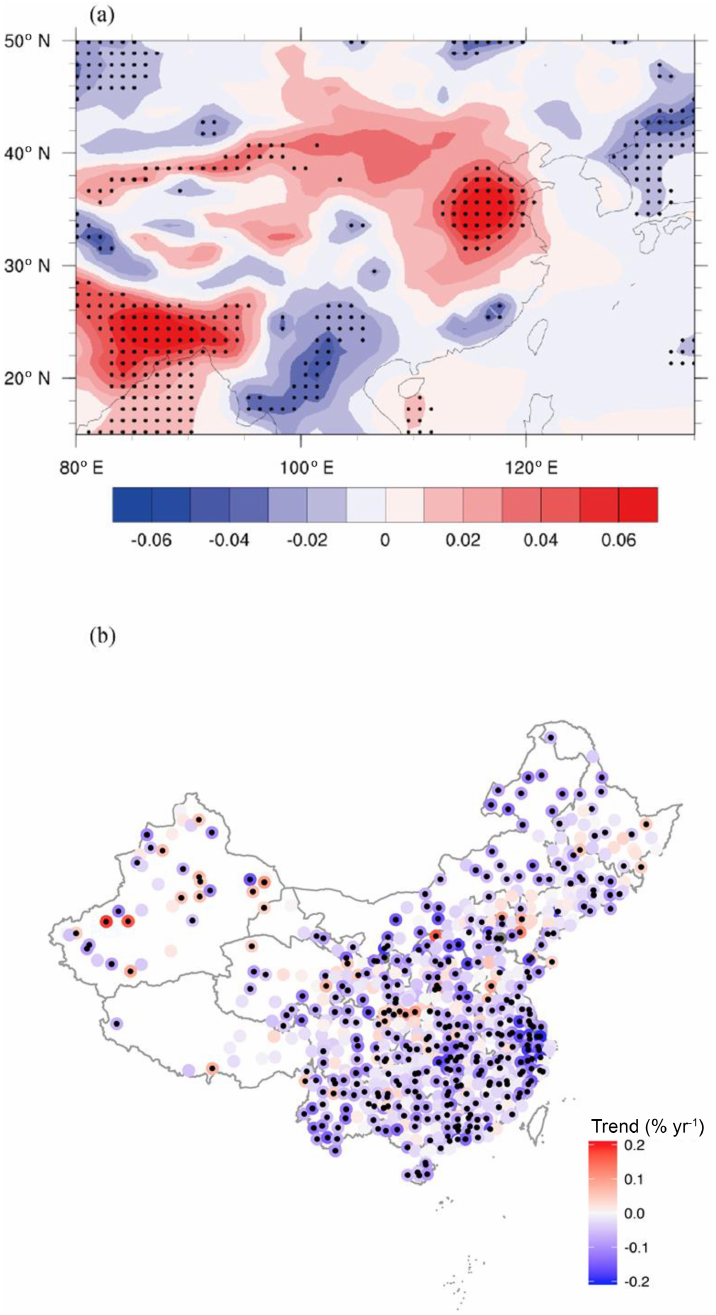
Figure 2. (a) Spatial distribution of linear trends of annual average RH (in %yr − 1 ) in China calculated for 1960–2017 historical simu- lations by an ensemble of 17 CMIP5 climate models; (b) same as (a) except derived from China Meteorological Administration (CMA) meteorological stations. Small black dots denote those trends significant at 95% confidence